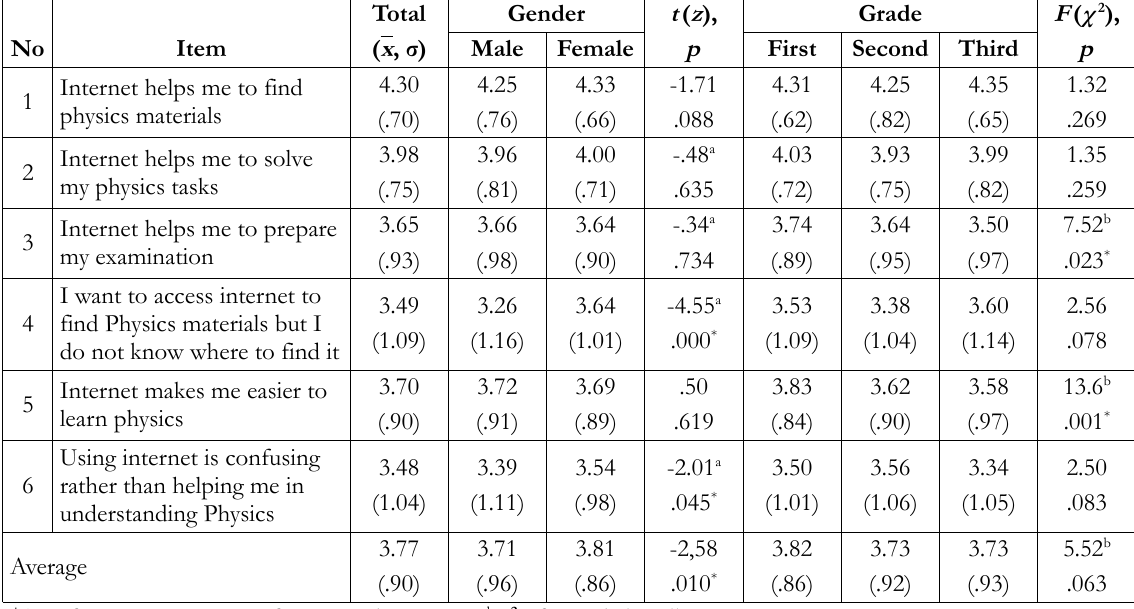
Table 7. Students’ perceptions about the benefit of internet in learning